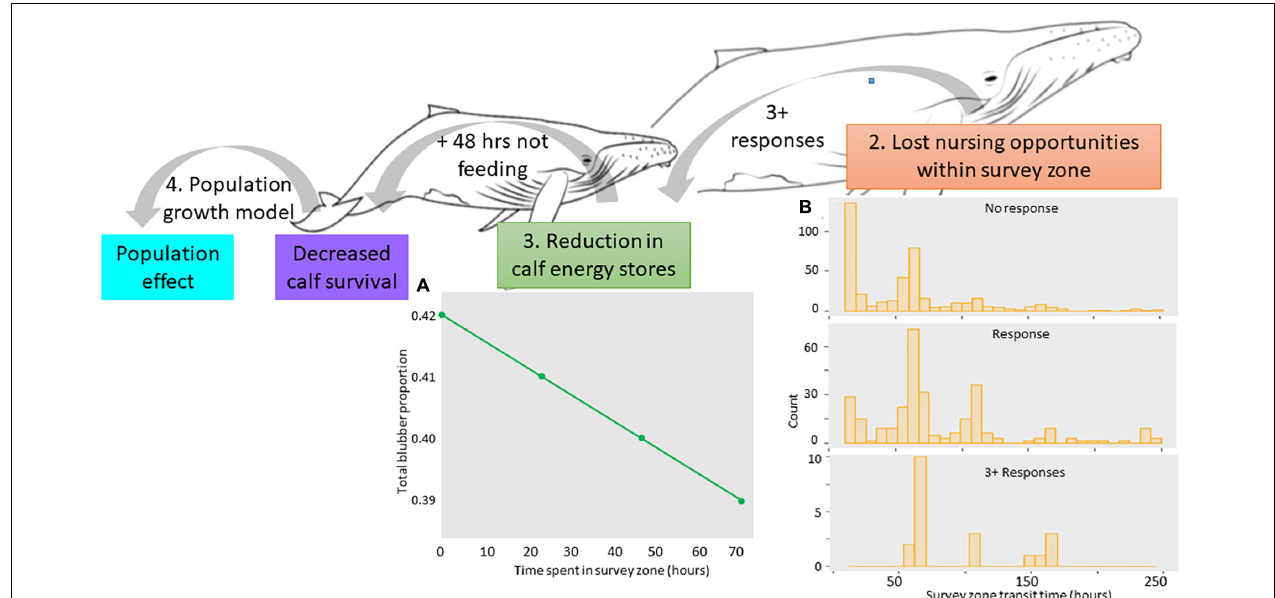
FIGURE 3 | Overview backwards approach starting with the population effect of decreasing calf survival. Calf survival was assumed to reduce due to lack of feeding opportunities, where it was assumed 48 h of not feeding would reduce the calf’s energy stores (A) , cause dehydration, and lead to calf mortality. To achieve this, we assumed the seismic survey took place in a resting/nursing area, where female-calf pairs spent more time within the survey zone. We assumed those that responded more three or more times [of which all spent longer than 48 h within the survey zone; (B) ] would lose enough nursing opportunities to compromise the calf. (A) Results of the energetic model showing the change in the total proportion of blubber lost by a calf per delay day (measured as delay hours) assuming it was not feeding. (B) Results of the ABM showing distribution of the number of hours that lactating female-calf pairs agents spent within the seismic survey zone for those that were primarily resting. Distributions are separated into FC agents that didn’t respond, FC that responded, and FC agents responded three or more times to the seismic air gun array.